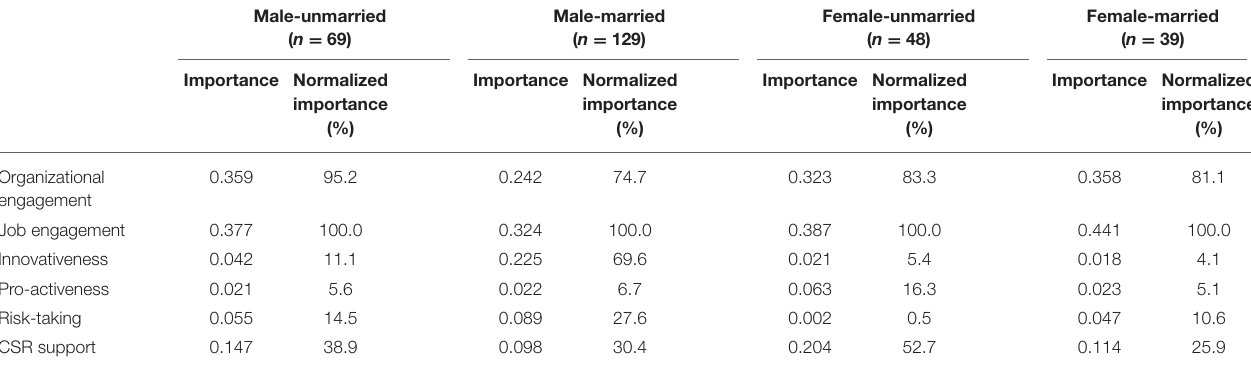
TABLE 6 | ANN analysis: the importance of intra entrepreneurship, organizational engagement, and job engagement for